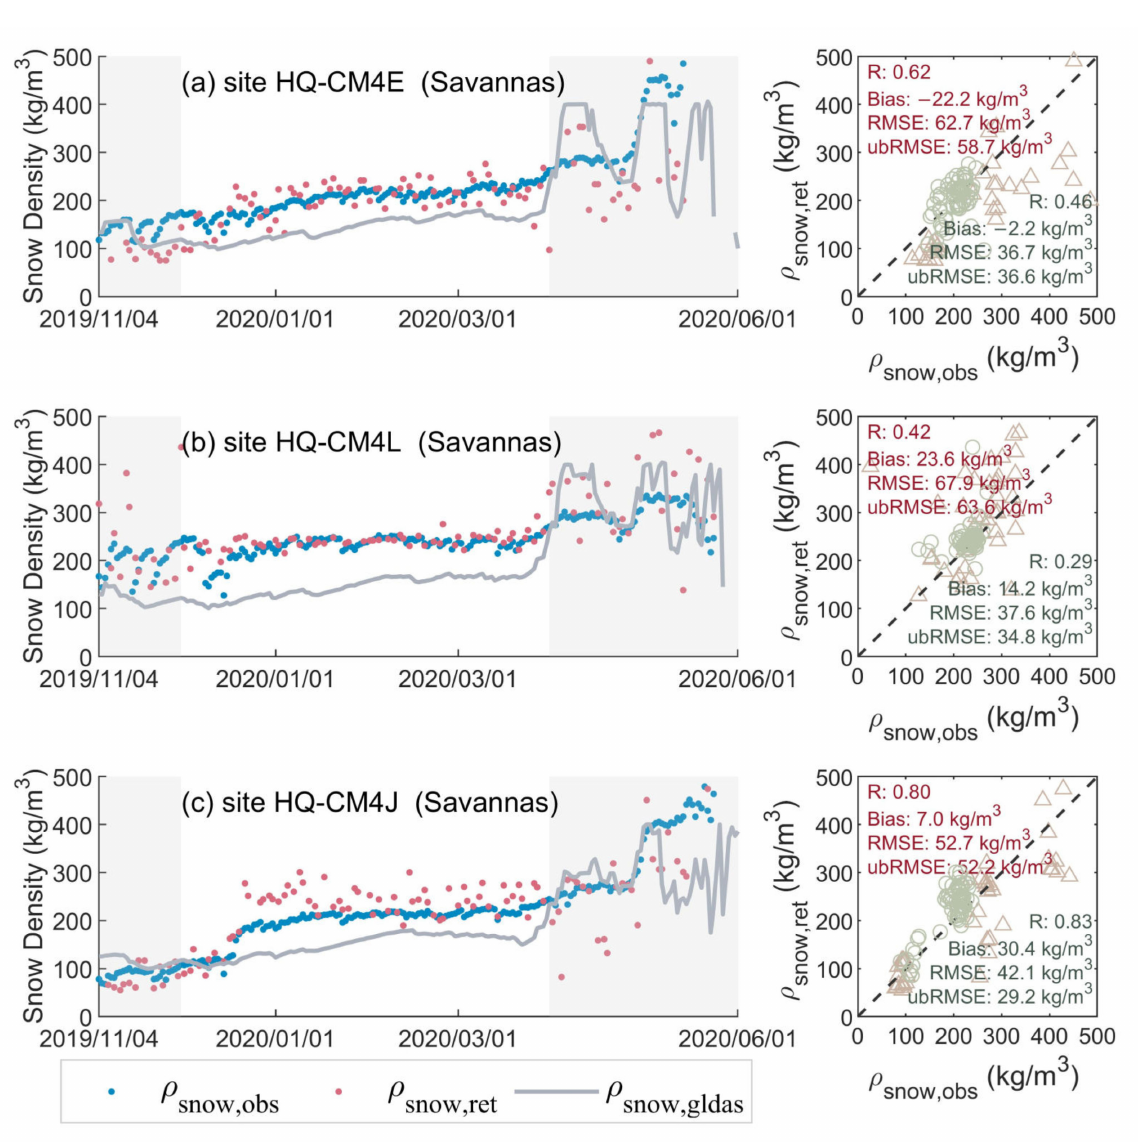
Figure 5. Time series (left) and scatterplots (right) of in-situ and retrieved snow density at the three stations with good performance among 43 stations: ( a ) HQ-CM4E, ( b ) HQ-CM4L, ( c ) HQ-CM4J, compared with the GLDAS snow density. In the right subplots, all points (pink triangles and green circles) and the statistics in the upper left corner present the validation in the entire snow season (October to June), whereas green circles and the statistics in the lower right corner present the validation from December to March. R is the Pearson correlation coefficient with the confidence interval of 95%, bias represents the mean bias, RMSE is the root-mean-squared error, and ubRMSE is the unbiased root-mean-squared